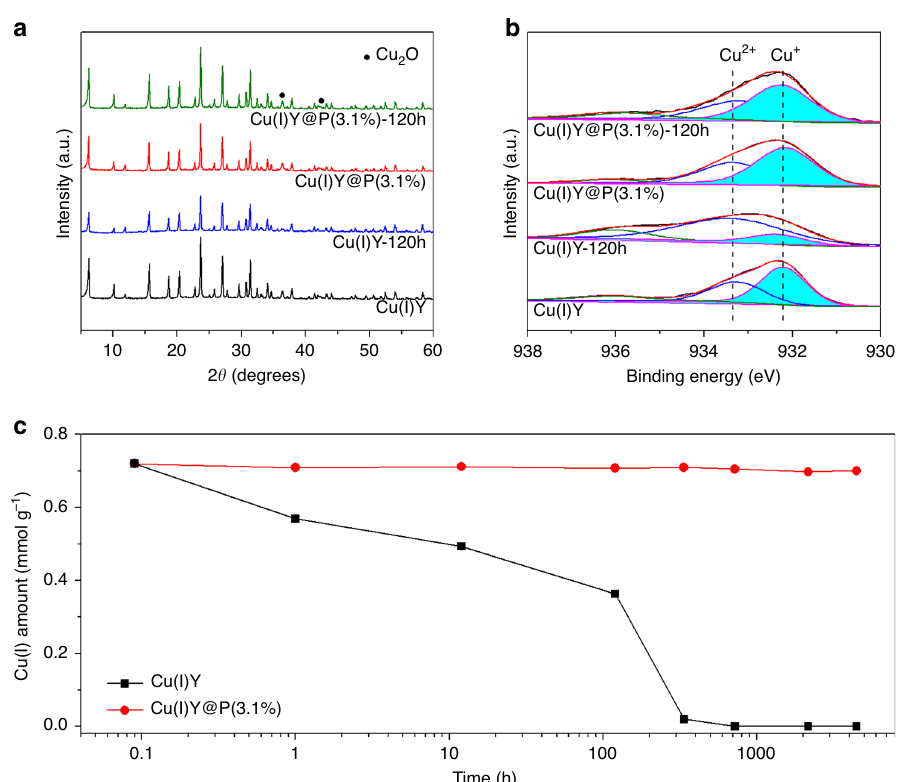
Fig. 3 Oxidation resistance of Cu(I). a XRD patterns and b XPS spectra of Cu(I)Y and Cu(I)Y@P(3.1%) after exposure to humid atmosphere (RH = 75%) for 120 h; c Cu(I) content of Cu(I)Y and Cu(I)Y@P(3.1%) after exposure to humid atmosphere (RH = 75%) for 6